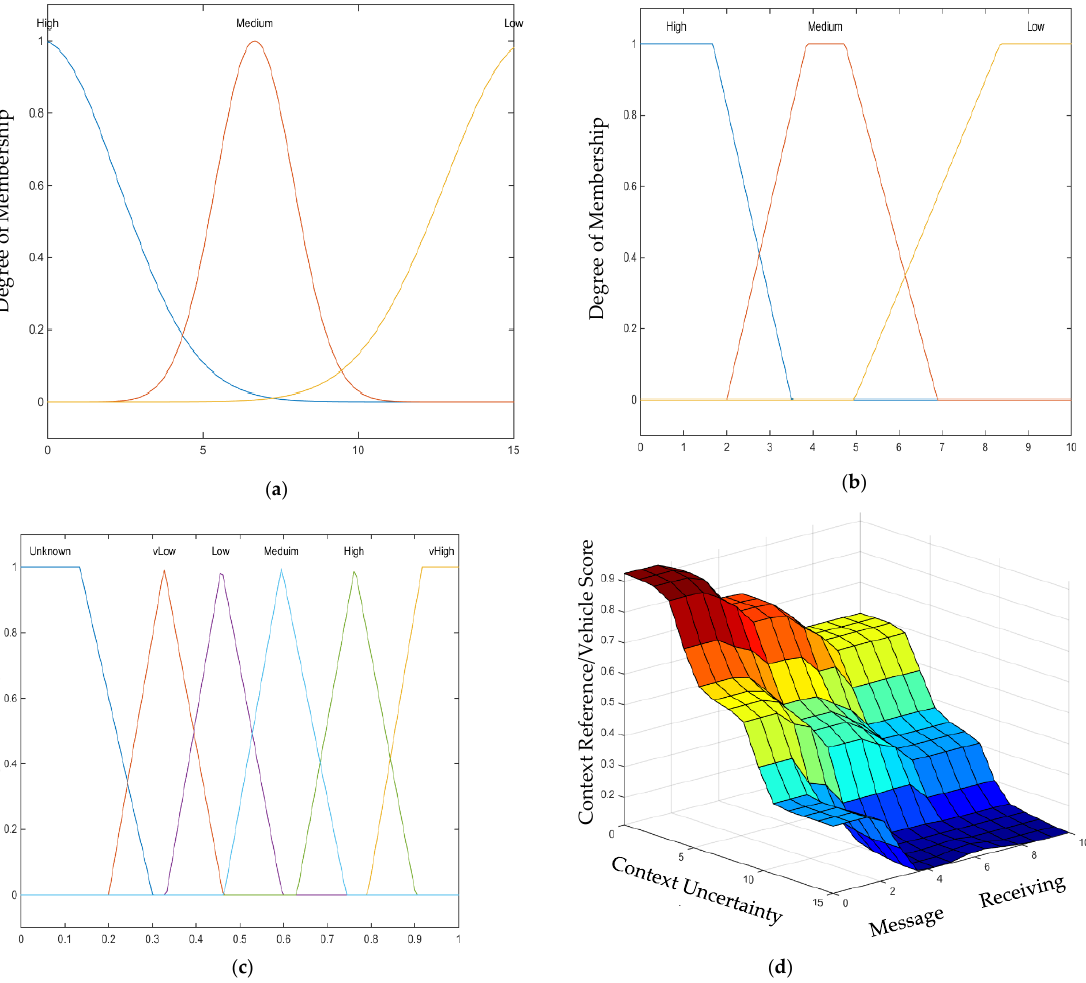
Figure 2. Context reference/vehicle score fuzzy model. ( a ) Context Uncertainty (Innovation Error). ( b ) Message Receiving Rate. ( c ) Context Reference/Vehicle Score. ( d ) Context Reference/Vehicle Score.